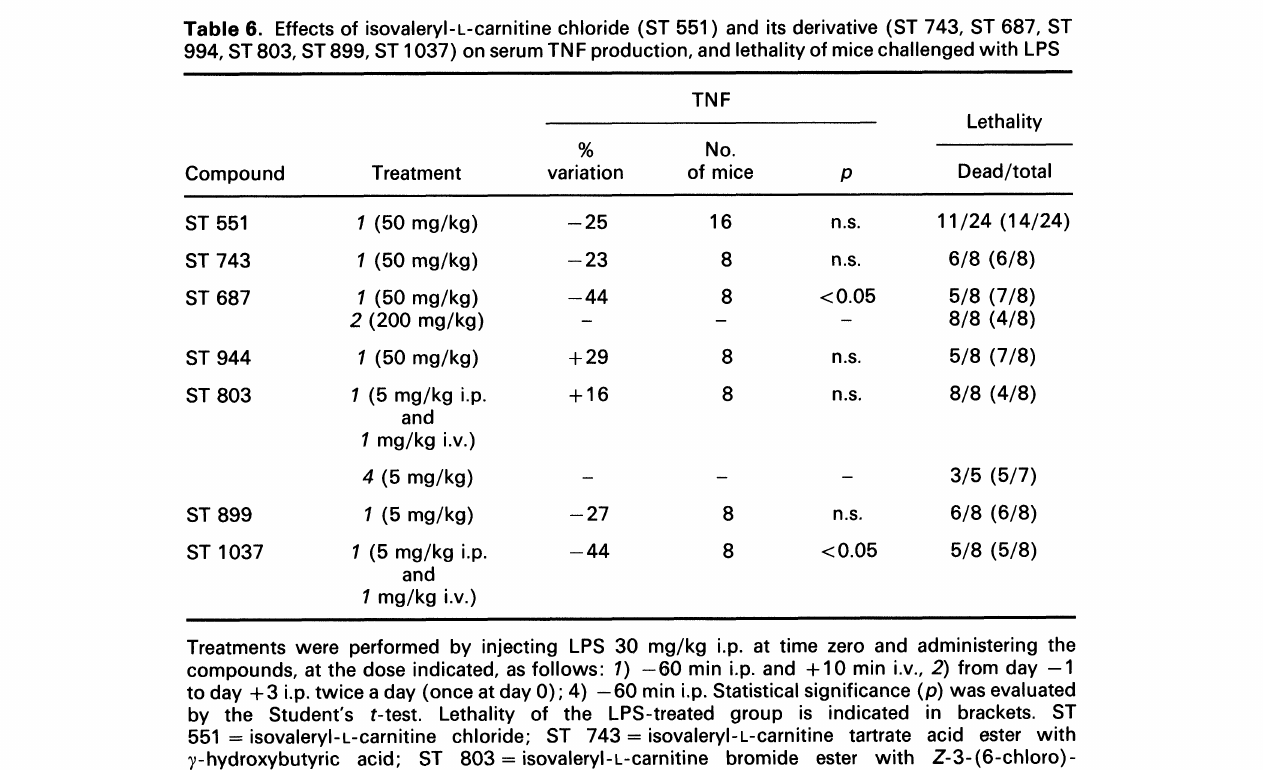
Table 6. Effects of isovaleryI-L-carnitine chloride (ST 551 and its derivative (ST 743, ST 687, ST 994, ST 803, ST 899, ST 1037) on serum TNF production, and lethality of mice challenged with LPS